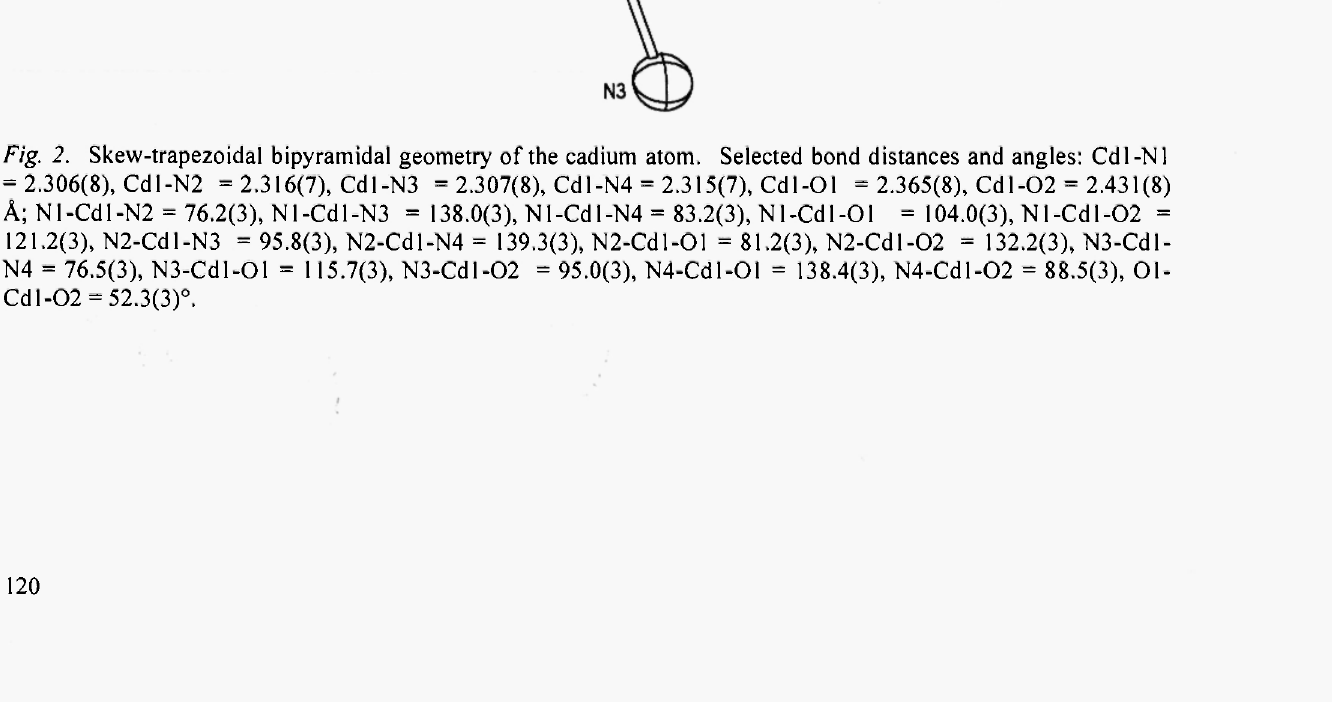
Fig. 1. ORTEP drawing of Cd(C 8 H 4 04)(C2oH4oN4)-2H20 at the 30% probability level; the water molecules are not shown.